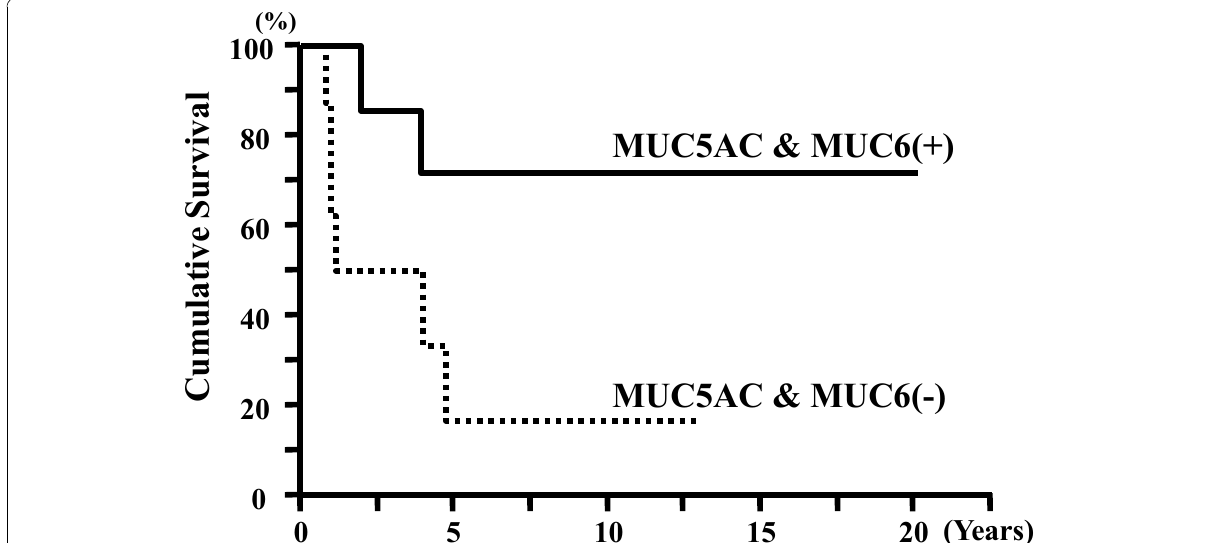
Figure 7 Cumulative survival of patients with immunohistochemical other-type tumors . Patients with tumors showing coexpression of MUC5AC and MUC6 showed significantly better survival than those with tumors negative for expression of both MUC5AC and MUC6 (p =